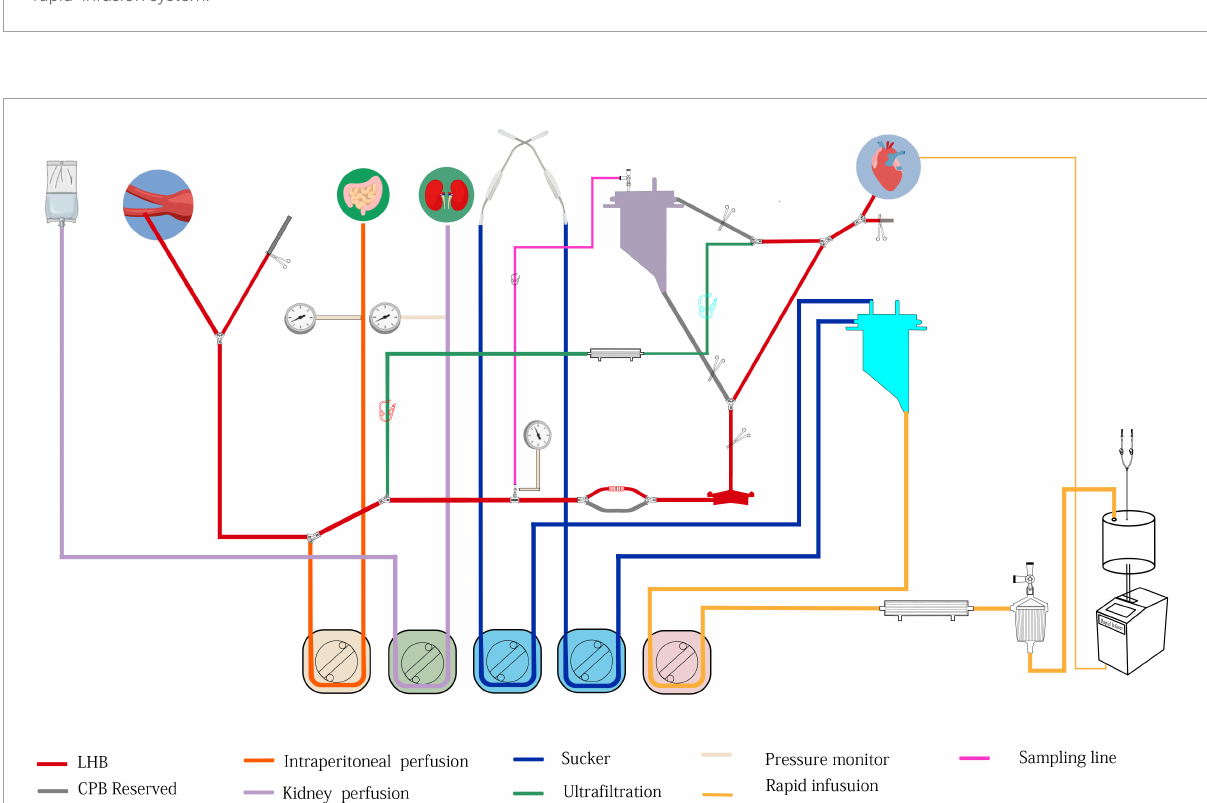
FIGURE6 The structure of modular multifunctional LHB circuit integrated with ultrafiltration and reserved pipelines for TAAA repair. The functions were indicted by different colors at the bottom of the figure.